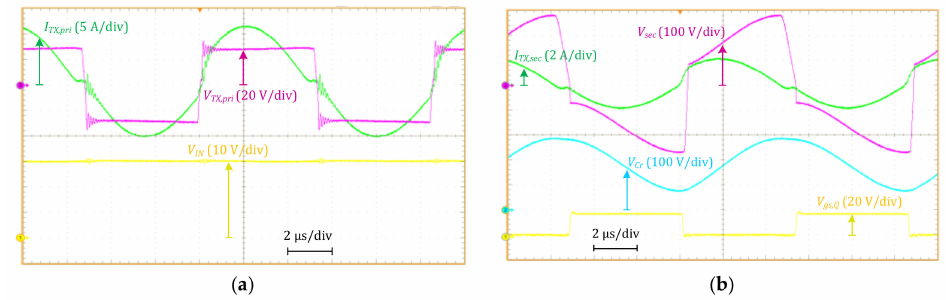
Figure 17. Steady-state waveforms of the converter in the pure - SRC conditions: ( a ) At the input and ( b ) output sides.